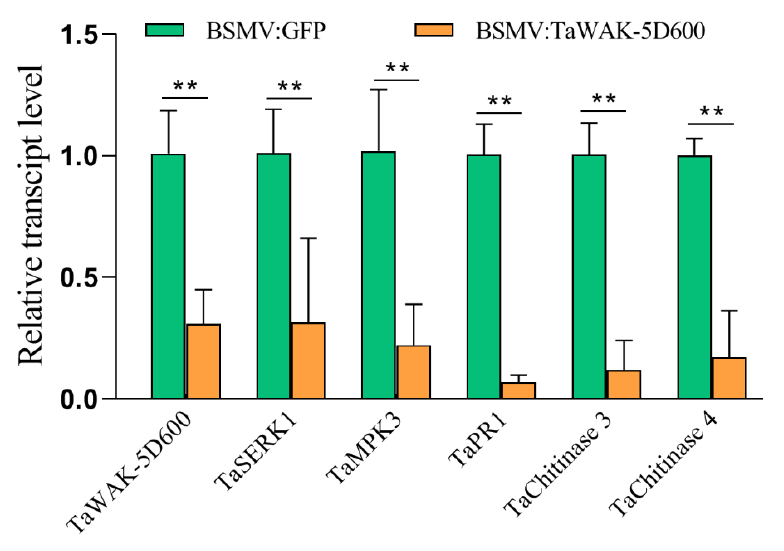
Figure 6. Transcript profiles of TaWAK-5D600 and defense-related genes in BSMV:GFP (control) and BSMV:TaWAK-5D600-infected wheat seedlings. Relative transcript abundances of TaWAK- 5D600 and the tested genes TaSERK1 , TaMPK3 , TaPR1 , TaChitinase3 , and TaChitinase4 in BSMV: TaWAK5D600-infected CI12633 seedlings were quantified relative to those in BSMV:GFP (control) seedlings. Statistically significant differences were calculated based on three replications via a Student’s t -test (** p < 0.01). TaActin was used as an internal